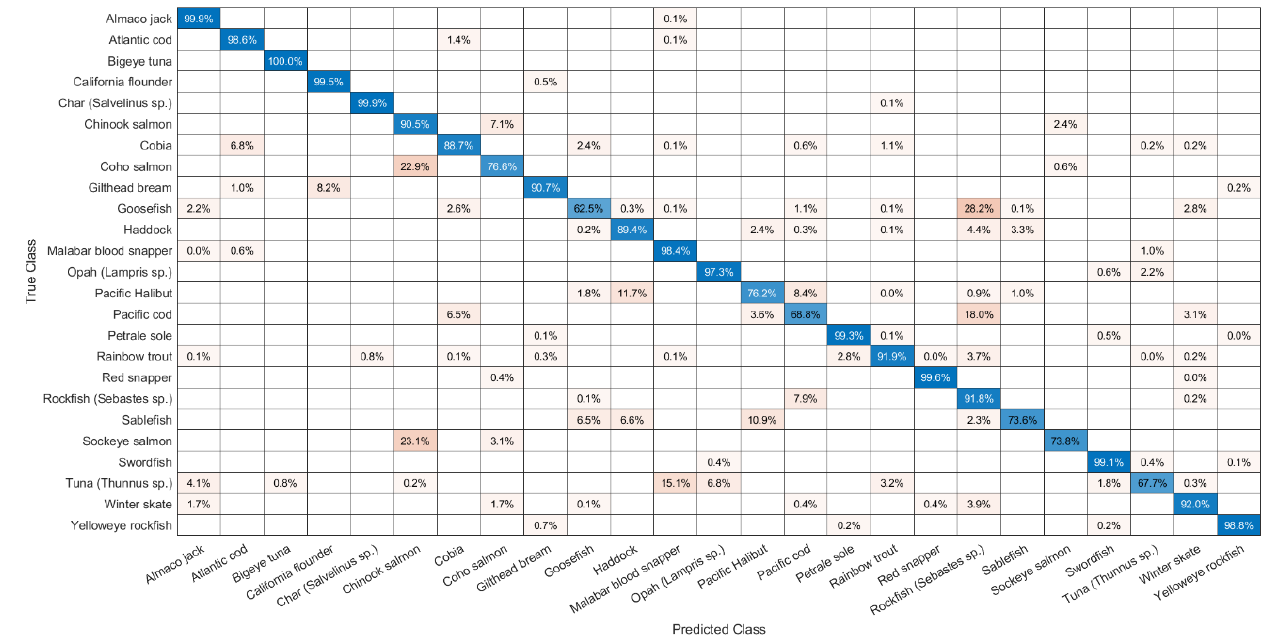
Figure 11. Confusion matrix for the single-mode fluorescence results with the k = 7 MLP (overall classification accuracy = 89.9%).